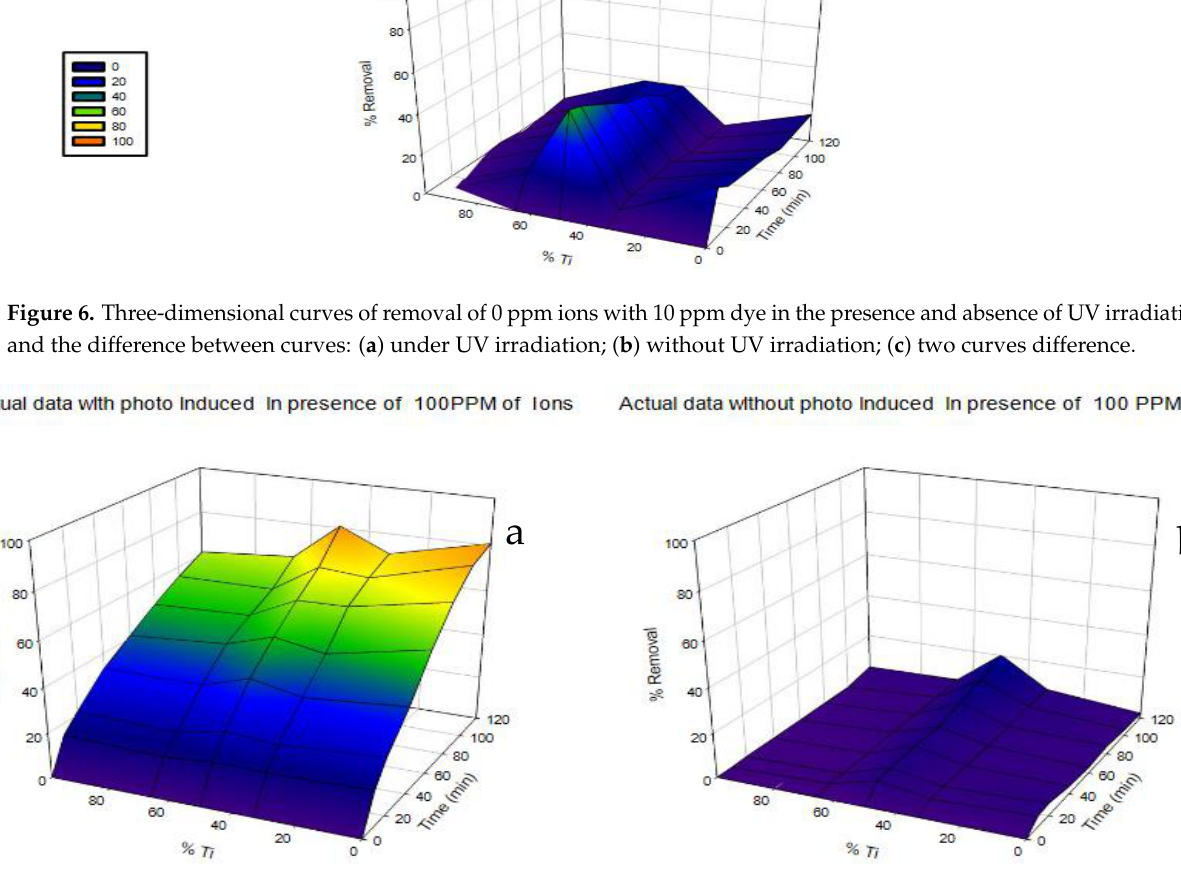
Figure 7. Three-dimensional curves of removal of 100 ppm ions with 10 ppm dye in the presence and absence of UV irradiation: ( a ) under UV irradiation; ( b ) without UV irradiation.